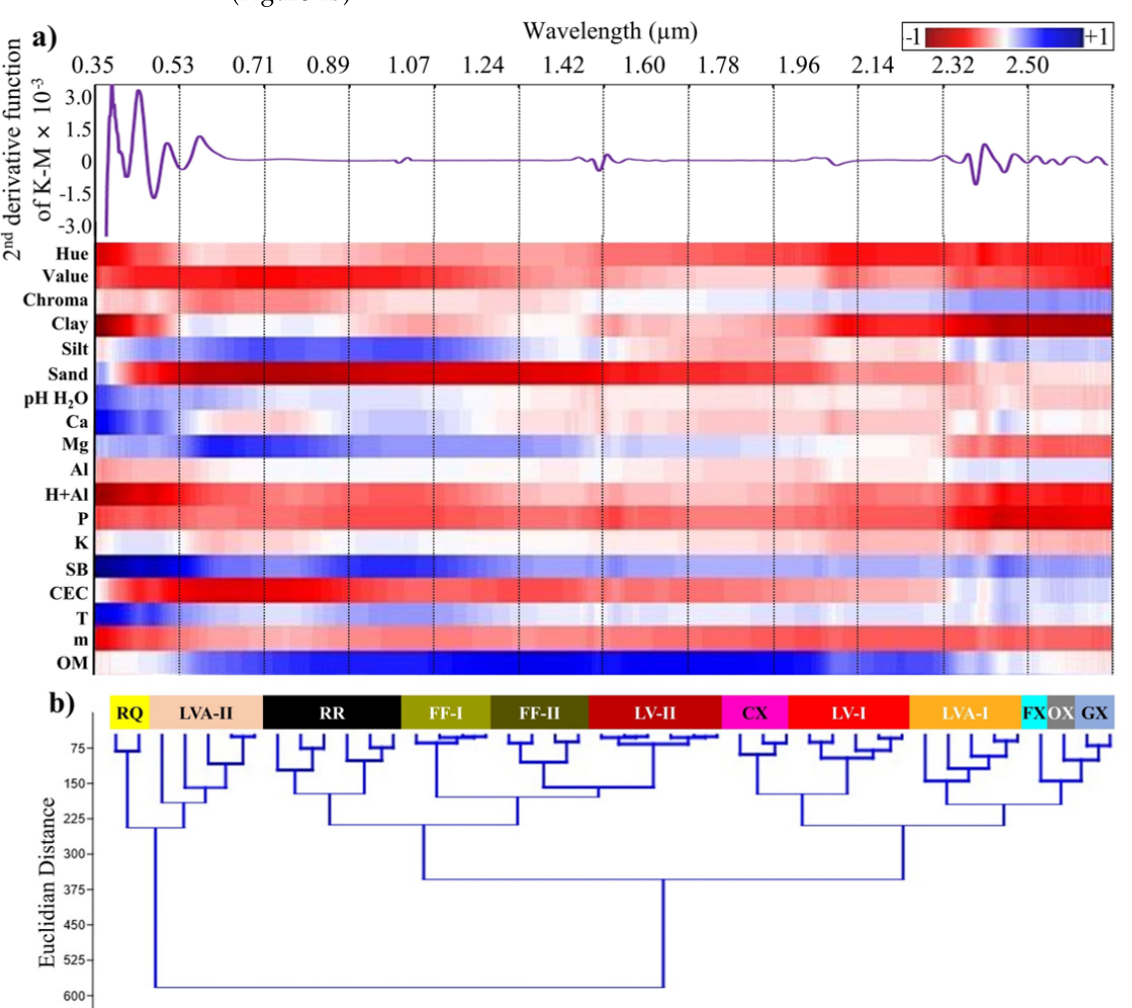
Figure 4. Data statistical analyzing: ( a ) Pearson’s correlation between soil attributes and different wavelengths of medium spectra; ( b ) Hierarchical clustering analysis by Euclidean distance similarity index based on texture (clay content). Where: Ca = Calcium, Mg = Magnesium, Al = Aluminium, P = Phosphorus, K = Potassium, SB = Sum of Bases, CEC = Cation Exchange Capacity, T = Bases Saturation, M = Aluminium Saturation, OM = Organic Matter; LV-I: LATOSSOLO